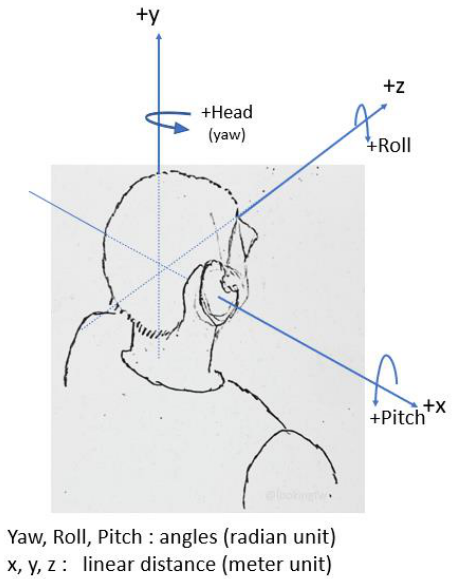
Figure 4. Object movement distances and angles.